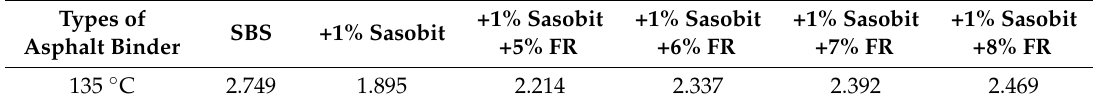
Table 7. Results of Brookfield rotational viscosity test (Pa ·